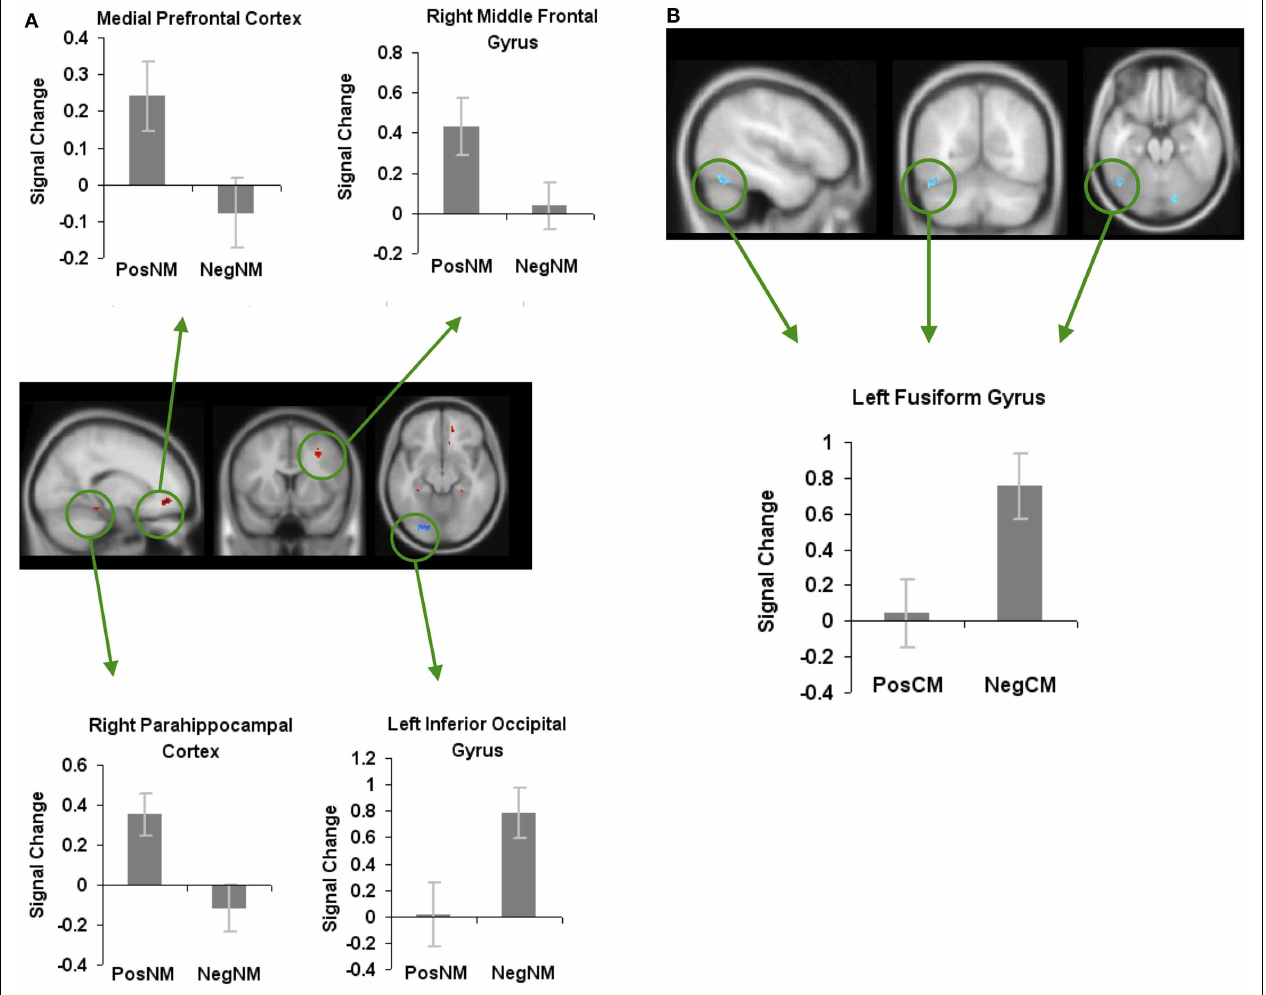
negatively valenced conventional metaphors . All clusters are illustrated at a threshold of p < 0.001 (uncorrected) combined with a cluster size of at least 50 voxels or 400mm 3 in volume. Mean beta weights for each condition extracted from the clusters illustrated in the specific contrasts of interest are revealed in the bar